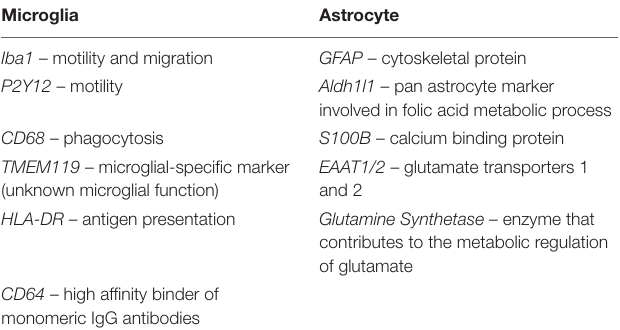
TABLE 2 | Most common microglia and astrocyte immunomarkers and their functions.